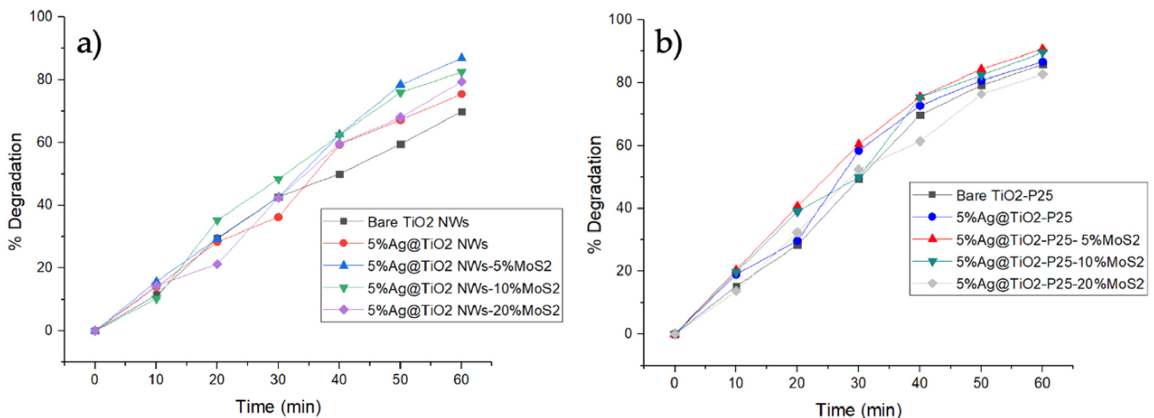
Figure 6. Raman spectra of 5%Ag@TiO 2 -P25-5%MoS 2 ( a ), 5%Ag@TiO 2 -P25-10%MoS 2 ( b ), 5%Ag@TiO 2 -P25-20%MoS 2 ( c ), 5%Ag@TiO 2 NWs-5%MoS 2 ( d ), 5%Ag@TiO 2 NWs-10%MoS 2 ( e ), and 5%Ag@TiO 2 NWs-20%MoS 2 ( f ).